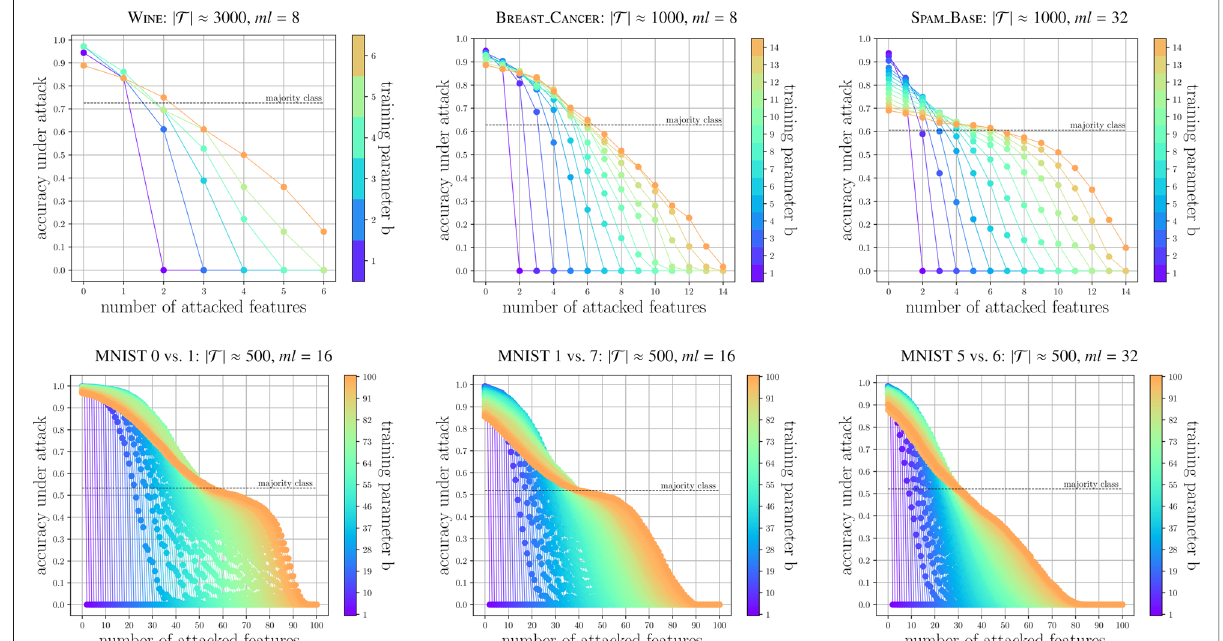
Fig. 2 Accuracy lower bounds for large b with